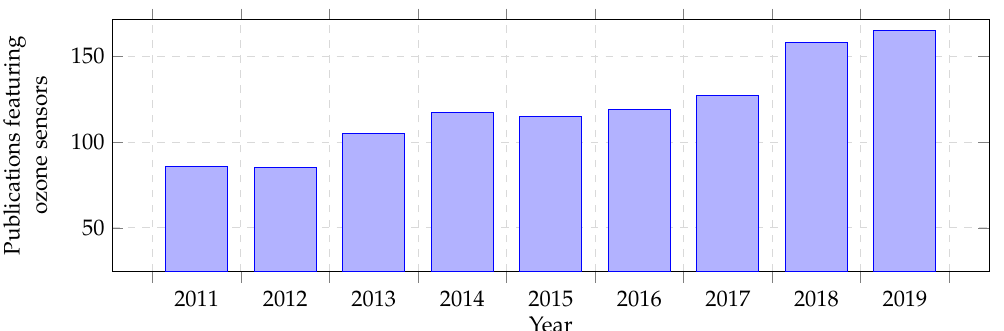
Figure 2. Number of publications featuring ozone sensors. Source: Scopus. Data extracted on 12 March 2020. All documents containing ozone and sensor were considered in the query and these documents were subdivided into the respective